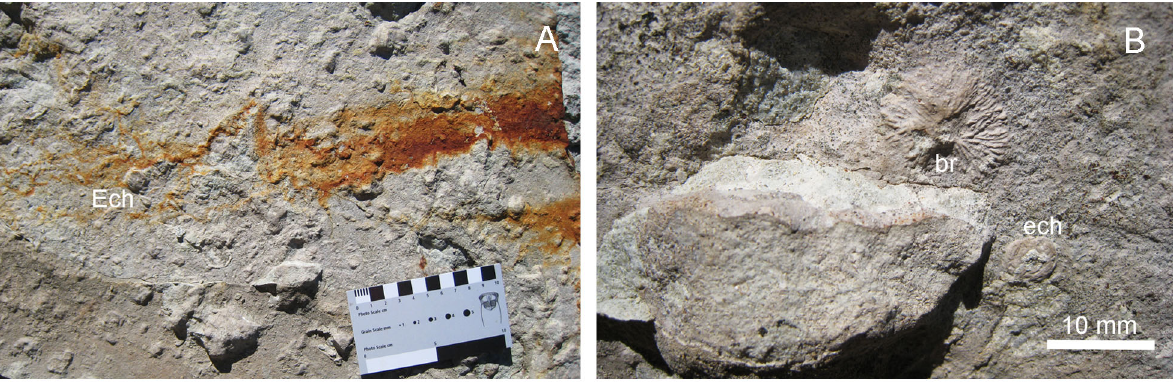
Fig. 2. A , hardground surface; Ech, large echinoderm holdfast, Pakri Formation, Darriwilian, Middle Ordovician, Pakri Cape, NW Estonia. TUG 1681-1. B , hardground surface; a ptilodictyid bryozoan holdfast (br) (TUG 1681-2) and small echinoderm holdfast (ech) (TUG 1681-3) cemented to the hardground from the Pakri Formation, Darriwilian, Middle Ordovician, NW